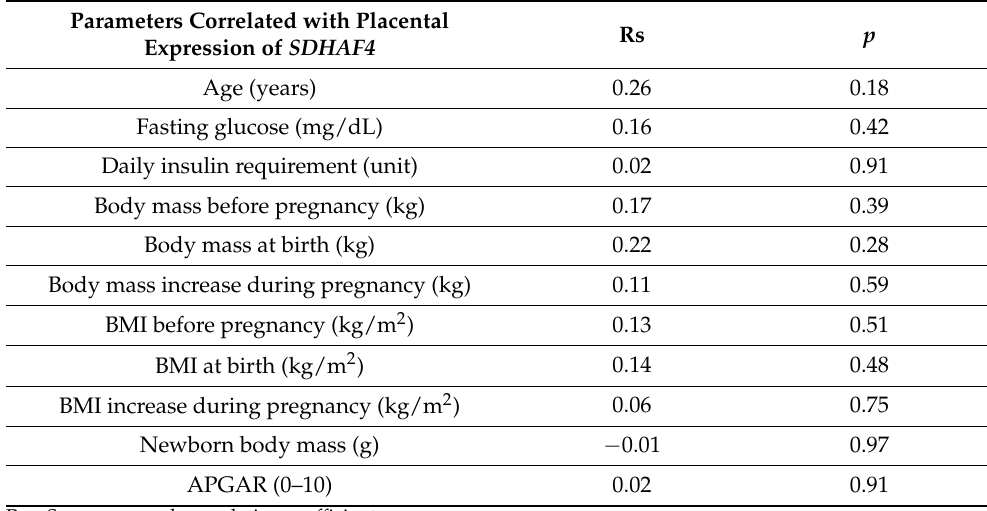
Table 6. Correlations between SDHAF4 expression in the placenta and clinical parameters in the GDM group [21–23].